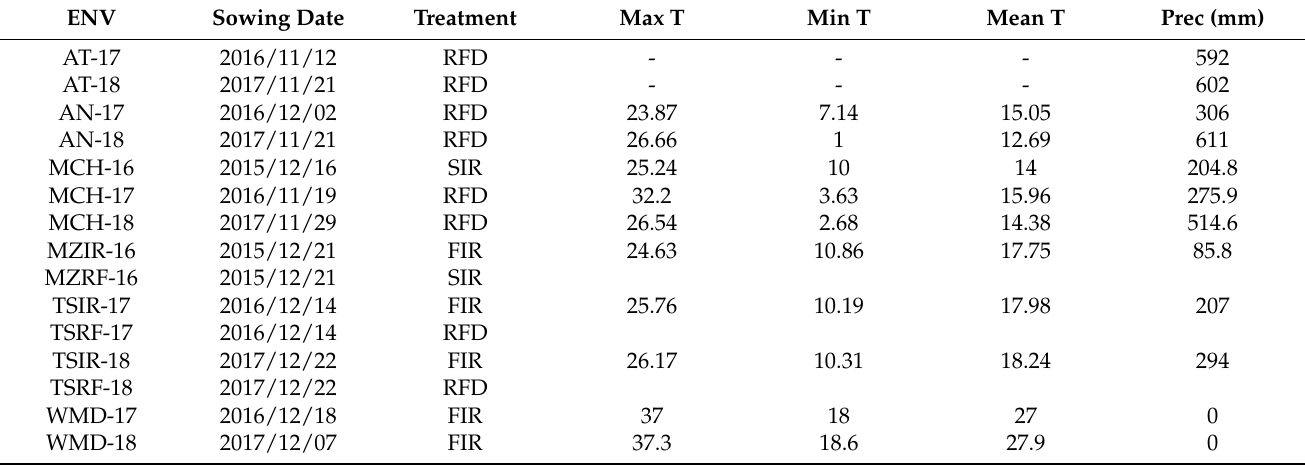
Table 5. Precipitation (mm), maximum, minimum, and average temperature ( ◦ C) in the 15 testing environments.